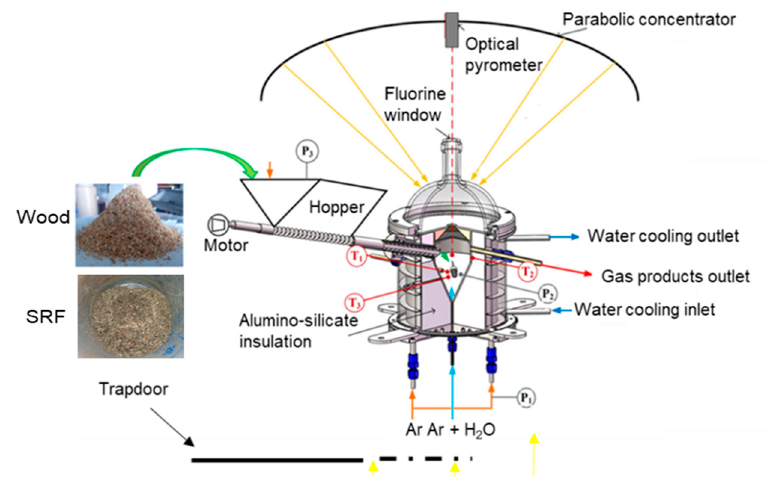
Figure 1. Scheme of the solar reactor for biomass gasification.